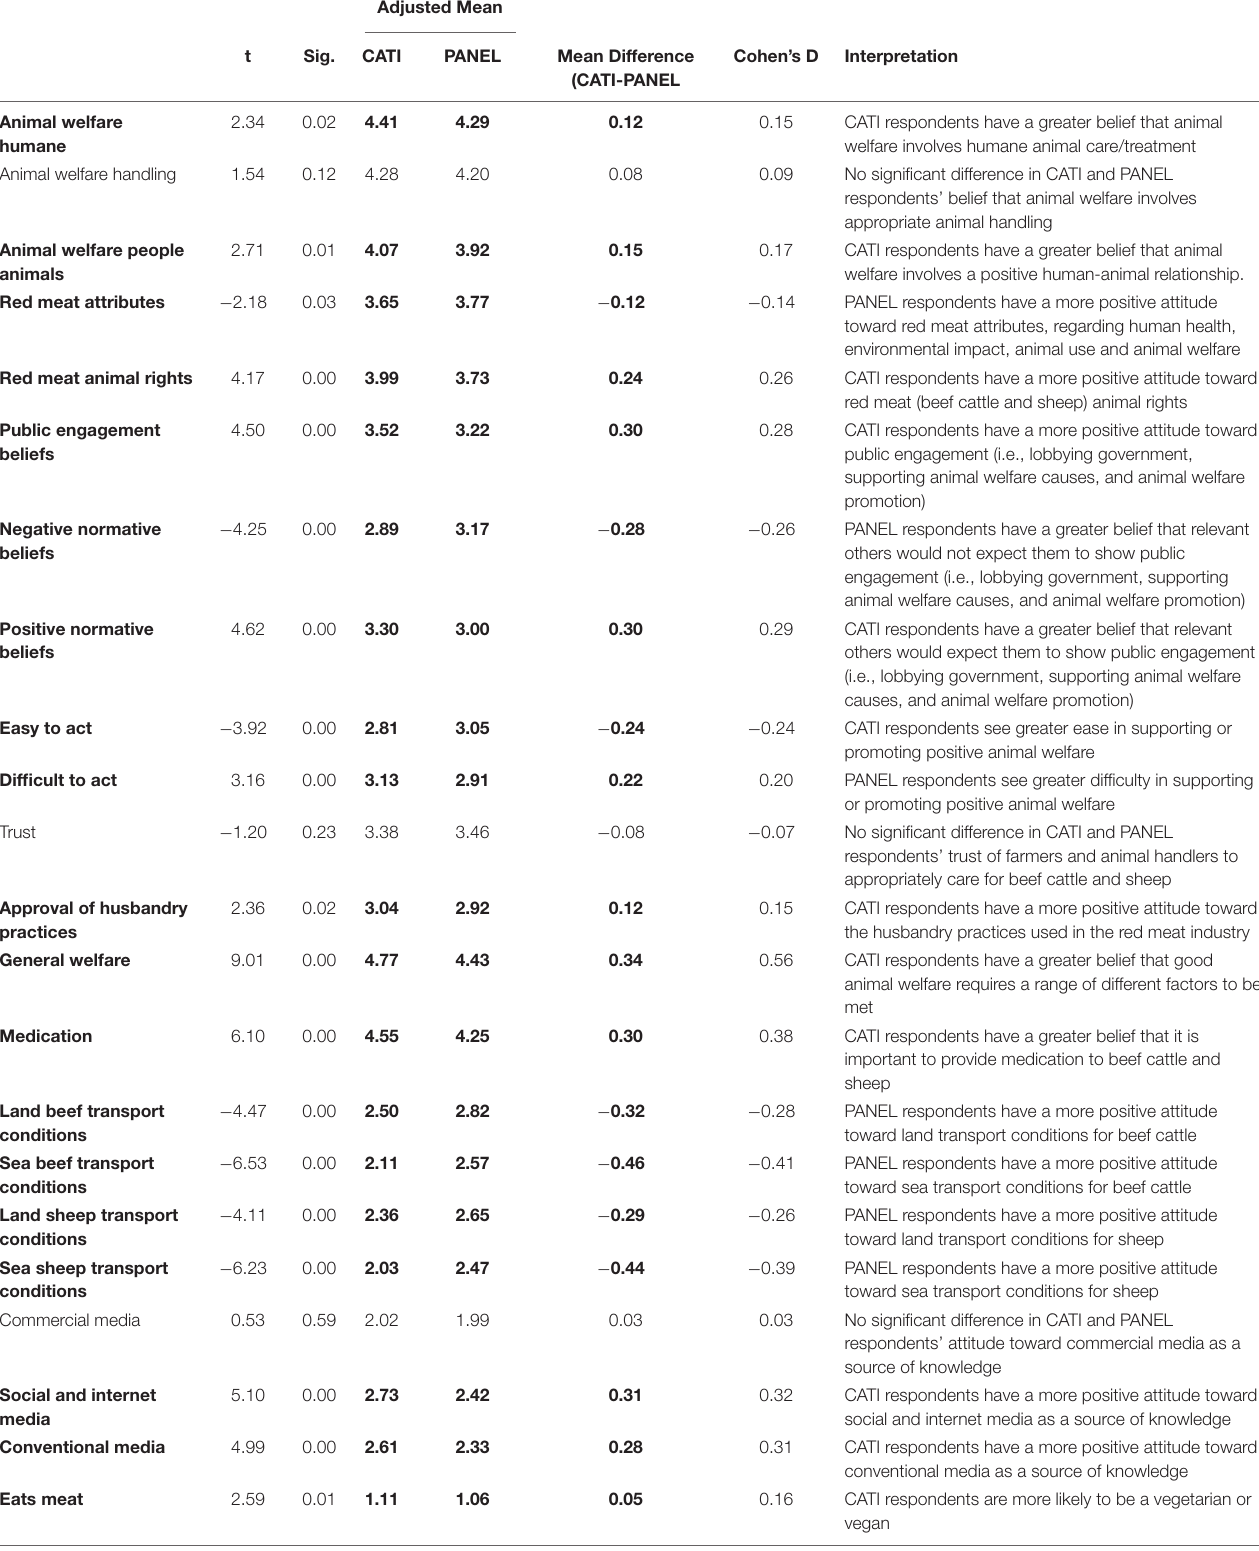
TABLE 4 | Independent 2-tailed t -tests (df = 1029) comparing the responses of the CATI and the PANEL respondents with education as a covariate. Adjusted Mean t Sig. CATI PANEL Mean Difference Cohen’s (CATI-PANEL